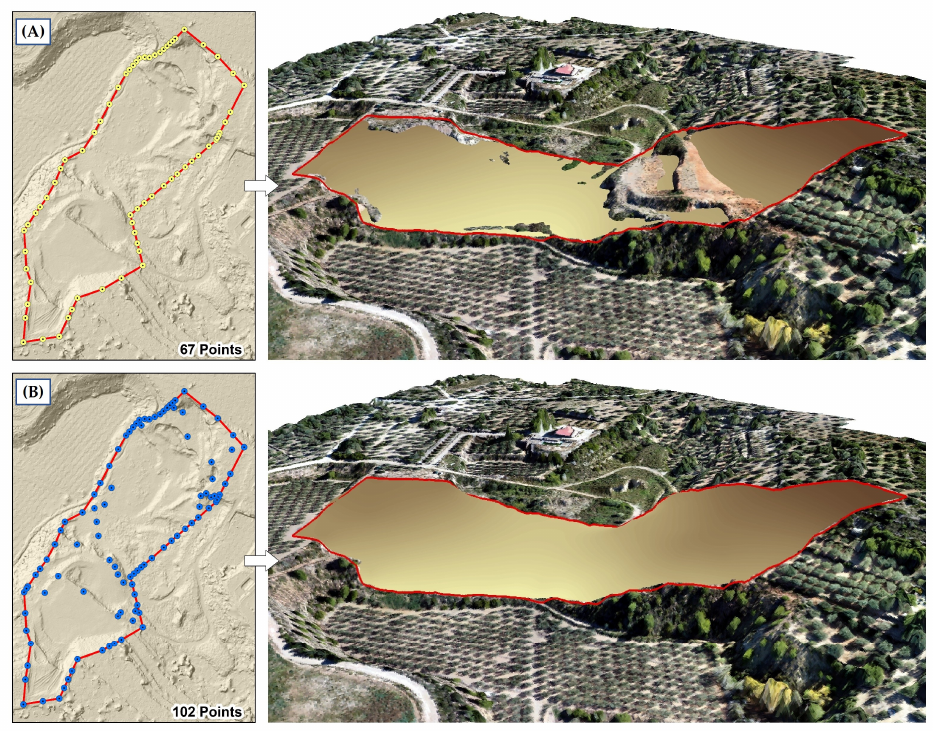
Figure 4. DEM(r) generated from ( A ) interpolated points only at the gravel limit and ( B ) adding points at maximum altitude locations inside the gravel